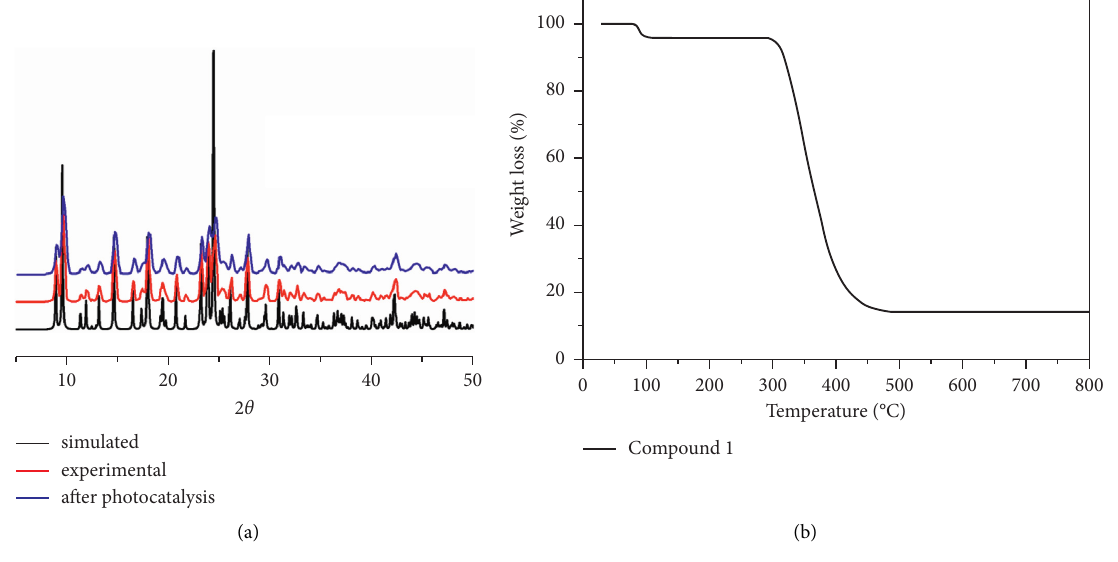
Figure 2: (a) PXRD patterns for 1 . (b) TGA curve of 1